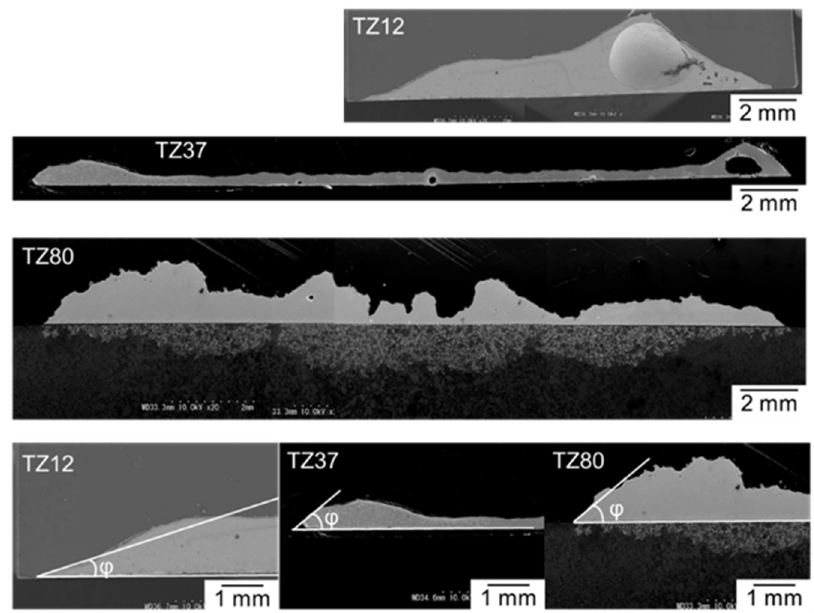
Figure 3. Macroscopic scanning electron microscopy (SEM) images of melted alloys on graphite plate. The apparent contact angles of the alloys are also defined.